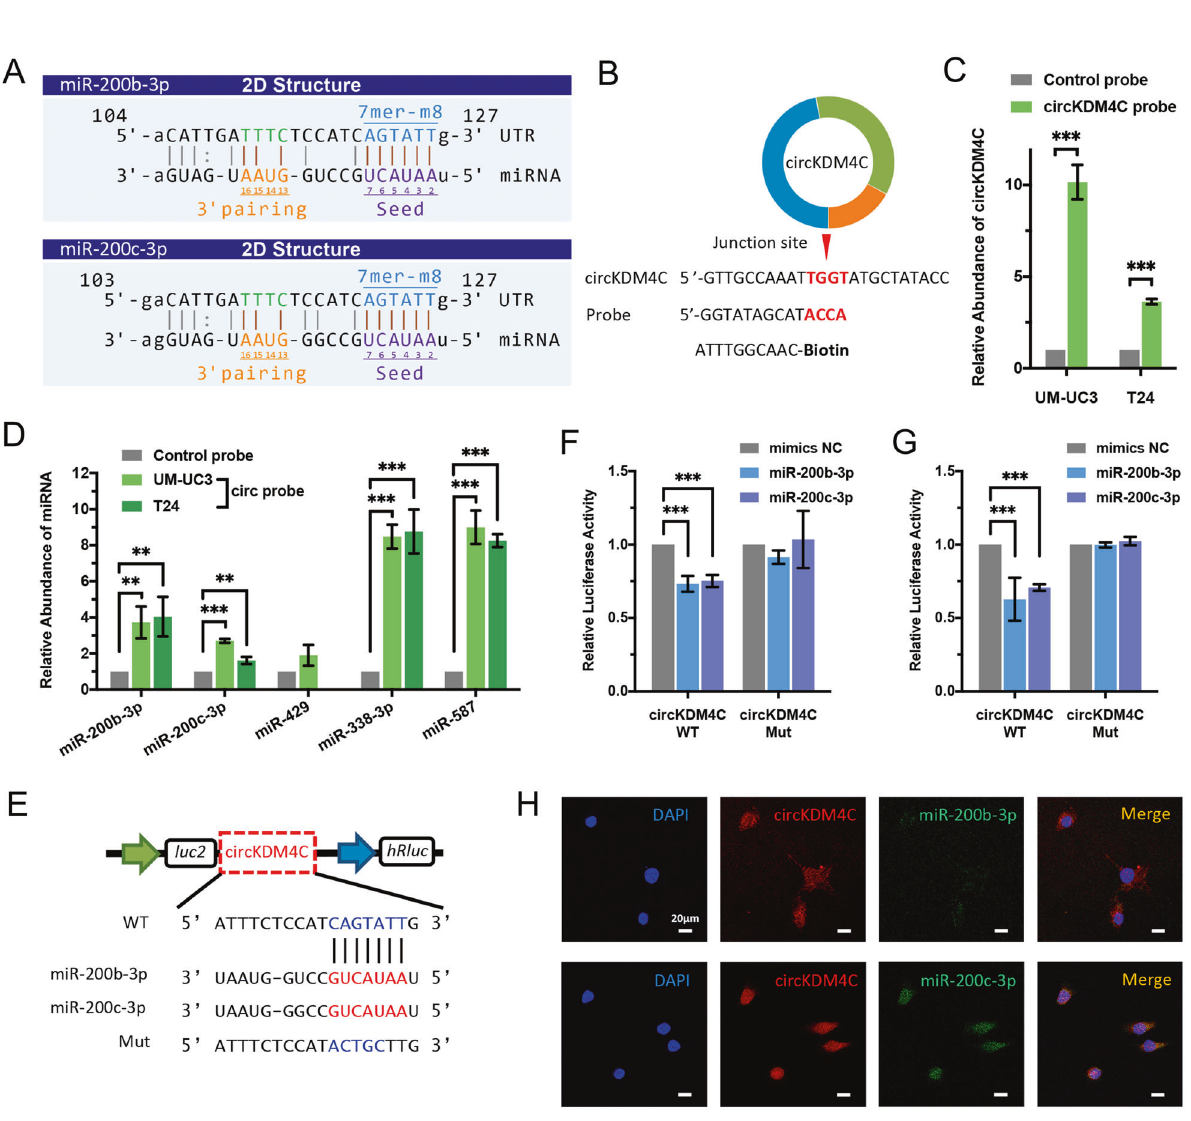
Fig. 3 circKDM4C serves as a sponge for miR-200b-3p and miR-200c-3p in BCa cells. A MiR-200b-3p/miR-200c-3p binding sites on circKDM4C predicted by TargetScan and miRanda. B Schematic illustration of the speci fi c probe for circKDM4C. circKDM4C probe is complementary with the back-splice junction of circKDM4C. C circKDM4C levels in UM-UC3 and T24 lysates after circRNA pulldown using circKDM4C probe or oligo-control probe. D Relative enrichments of candidate miRNAs in UM-UC3 and T24 cell lysates. E Schematic presentation of circKDM4C-WT and circKDM4C-Mut dual-luciferase reporter vectors. F, G Dual-luciferase reporter assays in UM-UC3 ( F ) and T24 ( G ) cells cotransfected with miR-200b-3p/miR-200c-3p mimics and circKDM4C-WT or circKDM4C-Mut vectors, respectively. H RNA FISH assay revealed the colocalization of circKDM4C and miR-200b-3p/miR-200c-3p in the cytoplasm in T24 cells (circKDM4C probe was Cy3- labeled, miRNA probes were FITC-labeled, and the nuclei were DAPI-stained). Scale bar = 20 μ m. Data are expressed as the means ± SD for n = 3. ** P < 0.01; *** P <